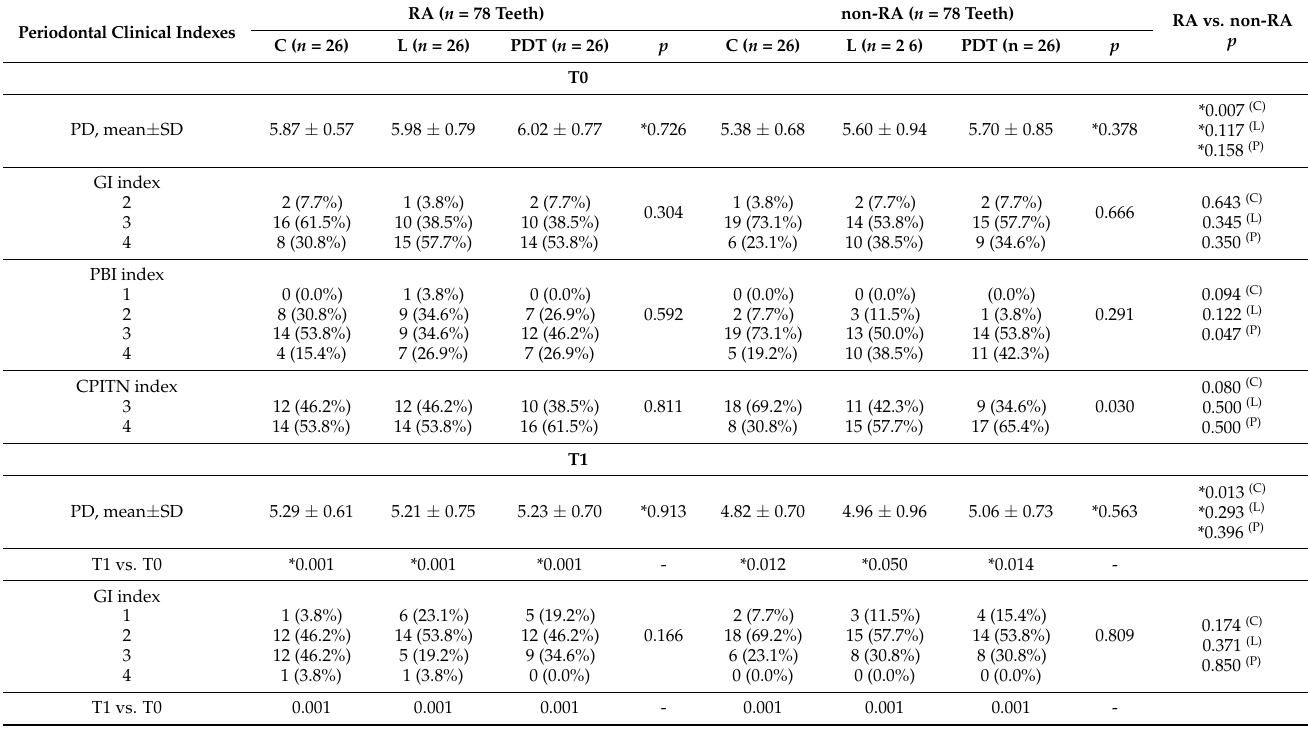
Table 2. Clinical periodontal indexes by treatment in RA and non-RA groups at baseline, T1, and T2, for individual